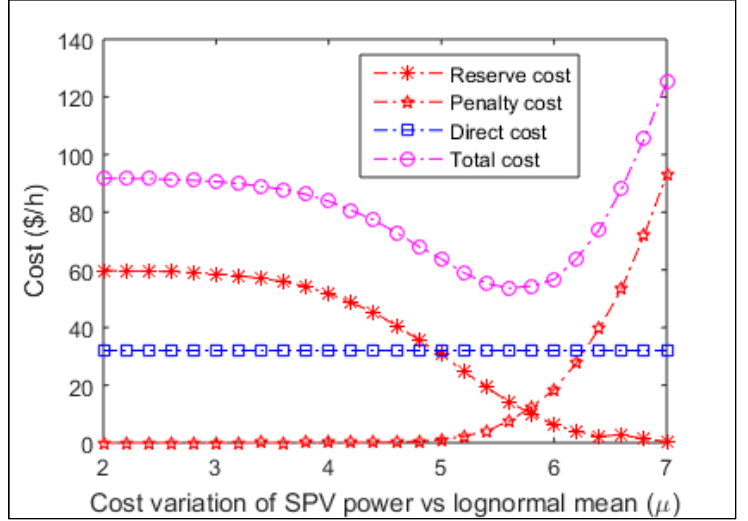
Figure 8. Cost vs. Weibull scale parameter ( c ) at bus #11.